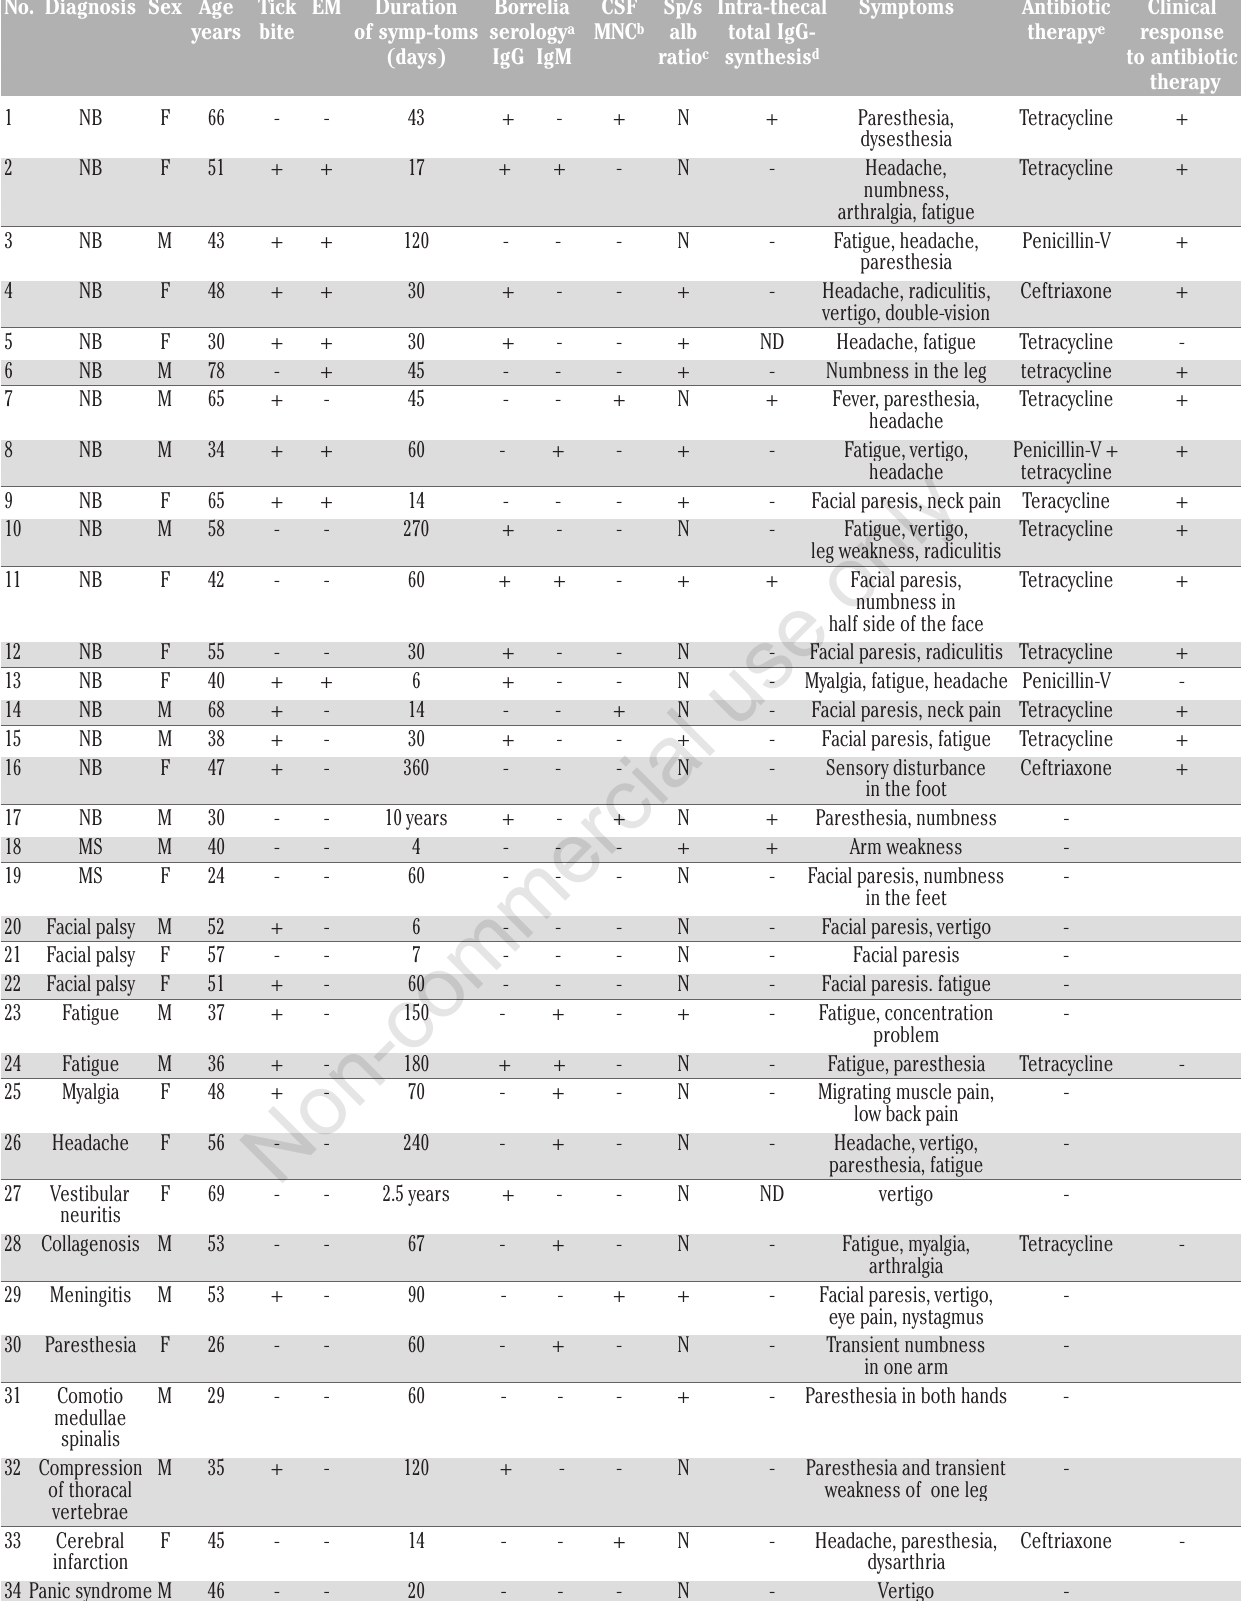
Table 1. Characterization of patients with possible neuroborreliosis without intrathecal Ig-synthesis against Borrelia antigen in the cere- brospinal fluid and controls with other diagnosesPat. No. Diagnosis Sex Age Tick